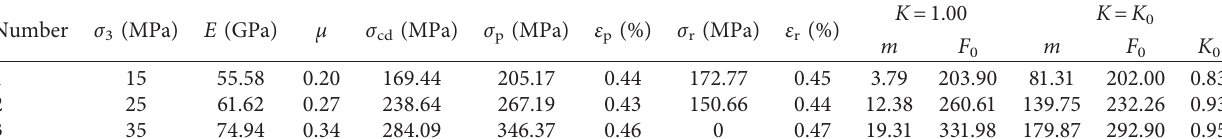
Table 1: The value of parameters in the constitutive model at different confining pressures.